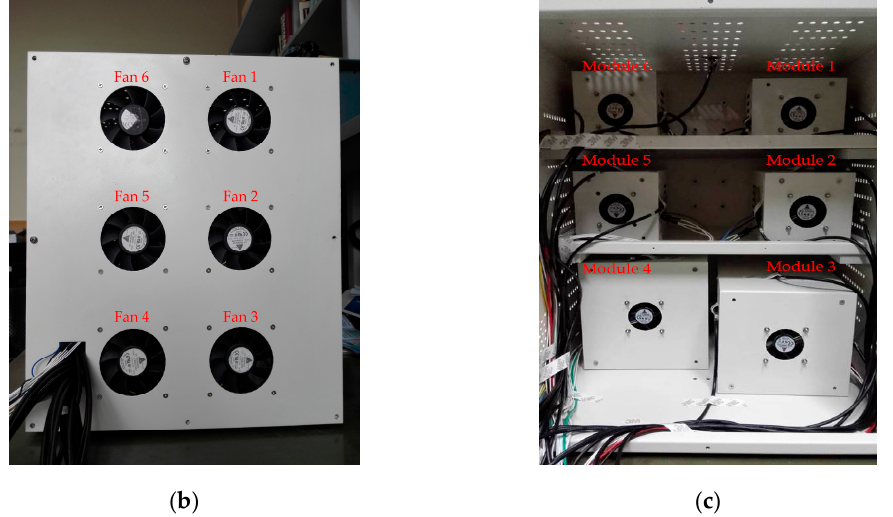
Figure 4. ( a ) Structure of the temperature sensing and control system; ( b ) Back view of the instrument mockup; ( c ) Internal layout of the mockup. PCB: printed circuit board.